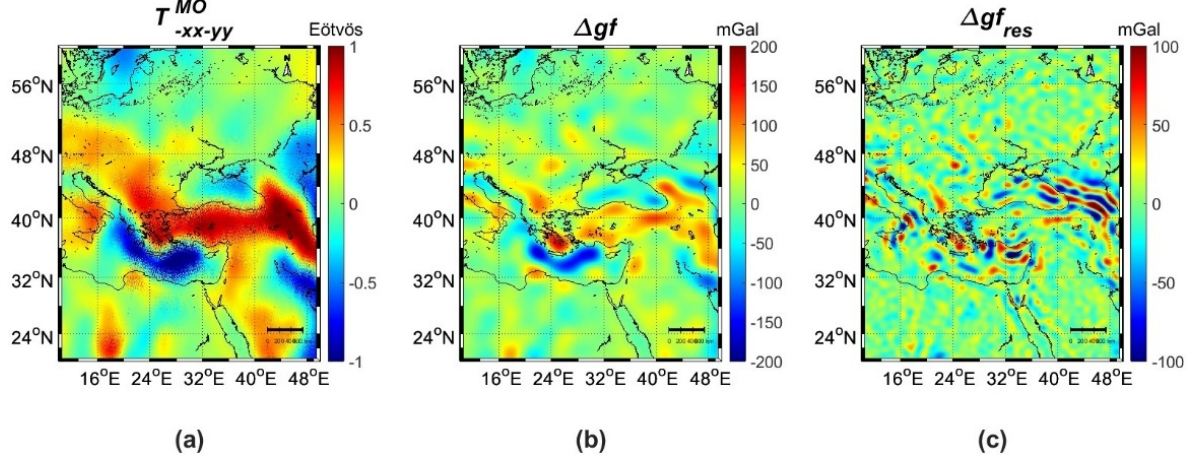
Figure 3. ( a ) The original 𝑇 (cid:3053)(cid:3053)(cid:3014)(cid:3016) at MO = 230 km, ( b ) the DC free-air gravity anomalies, ( c ) their re- ) with the ground data based on TIM_R6 d/o 300. siduals (𝛥𝑔𝑓 (cid:3045)(cid:3032)(cid:3046)